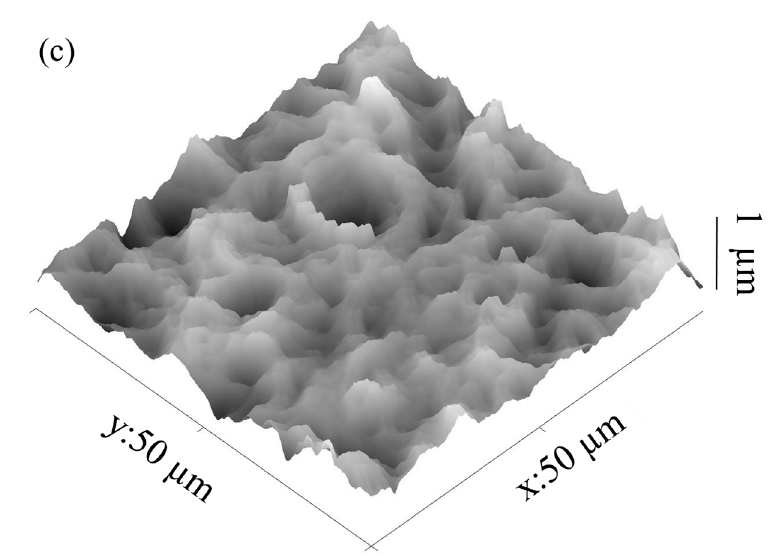
Figure 3. Three-dimensional (3D) atomic force microscopy (AFM) images of waxes in air. ( a ) Para ffi n (wax 1) roughness value (Ra): 73 nm, ( b ) sacrificial investment casting wax (wax 2) Ra: 133 nm and ( c ) Solidscape ® wax (wax 3) Ra: 117